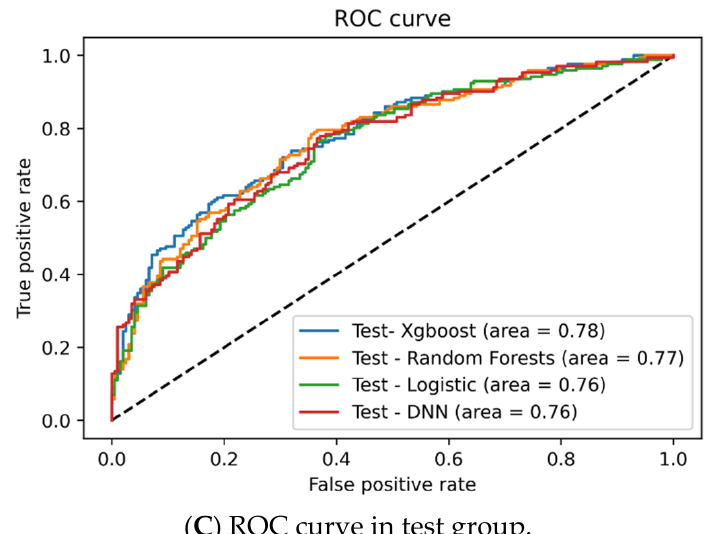
Figure 2. Prediction of insulin resistance in patients with CKD using XGboost, random forest, logistic regression, and DNN in train ( A ), validation ( B ), and test group ( C ). In the train group ( A ), RF had the highest AUC (0.94), followed by XGboost (0.91). In the validation group ( B ), AUCs of ROC were all >0.8 (highest being RF, 0.83). RF had higher accuracy (0.77), specificity (0.81), PPV (0.77), and NPV (0.77). The sensitivity was highest in DNN (0.74). In the testing group ( C ), all AUCs of ROC were >0.76 (highest being XGboost, 0.78). In addition, XGBoost also had higher accuracy (0.7) and NPV (0.71). RF had higher accuracy (0.7), specificity (0.78), and PPV (0.7). DNN had higher sensitivity (0.66) and NPV